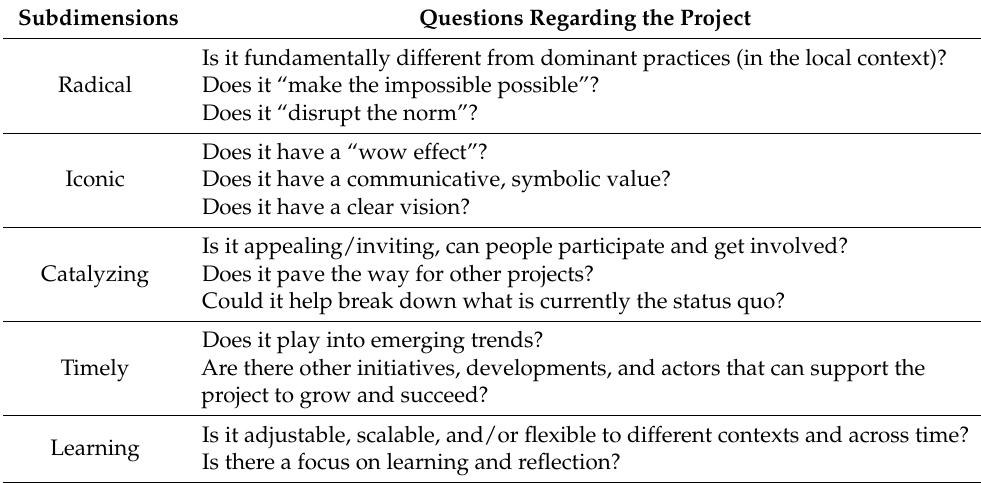
Table 1. Subdimensions framework to assess transformative potential.